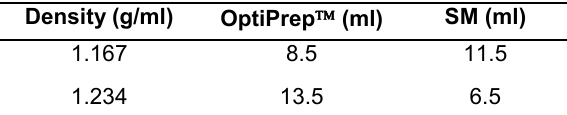
Gradient Solutions for Wheatgerm